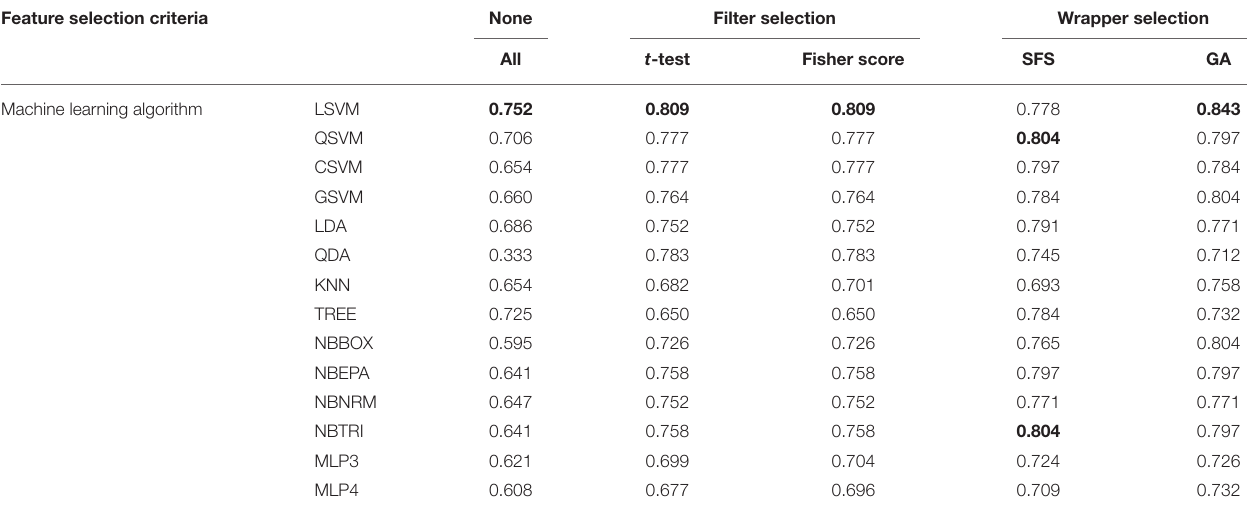
TABLE 4 | Specificity of models per feature selection method and classifier algorithm. Feature selection